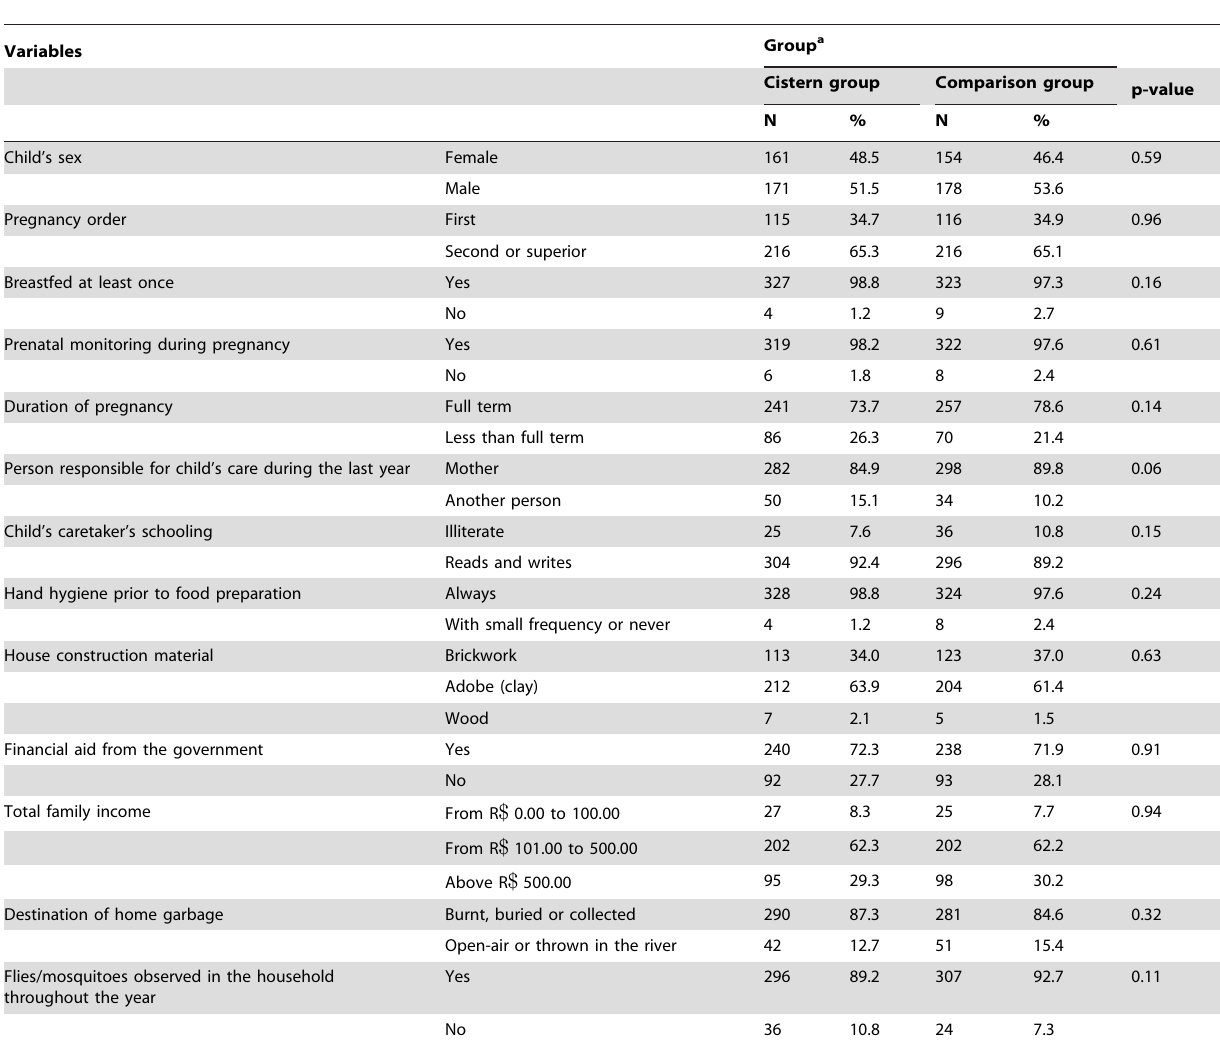
Table 1. Characteristics of children from cistern group compared with children from comparison